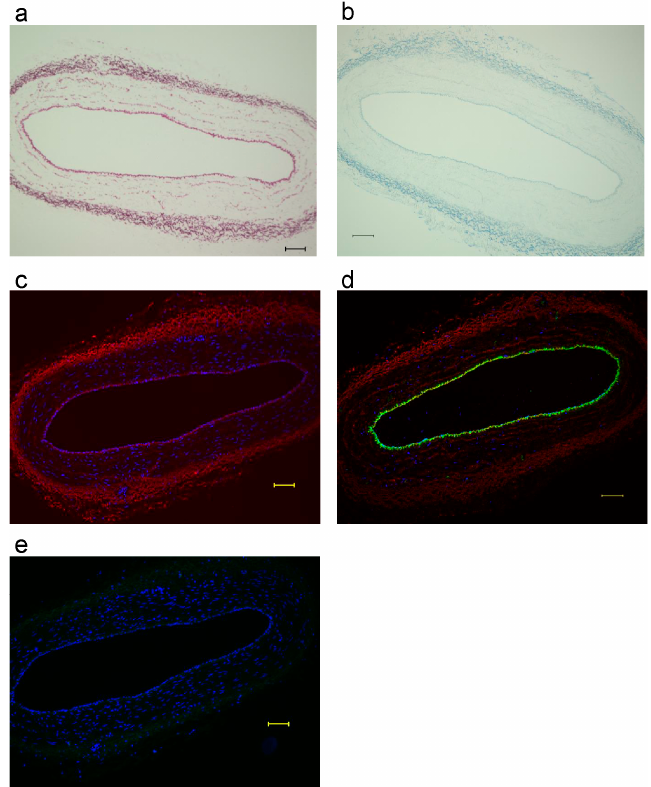
Figure 2. Histology of blood vessels: ( a ) Elastin: red; ( b ) FBXW2: blue; ( c ) FBXW2: red, DAPI: blue; ( d ) FBXW2: red, Von Willebranfactor: green, DAPI: blue; ( e ) Osteocalcin: green, DAPI: blue. Scale bar: 100 μ m.